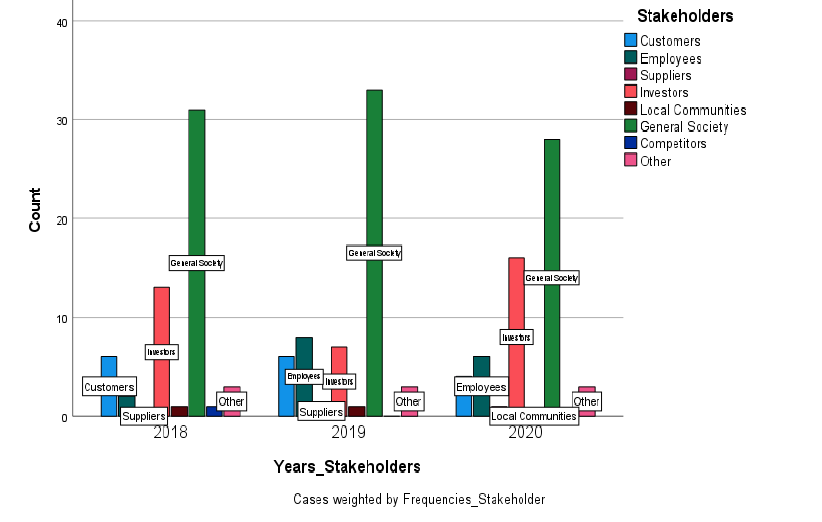
Figure 1: CSR Stakeholder Focus by